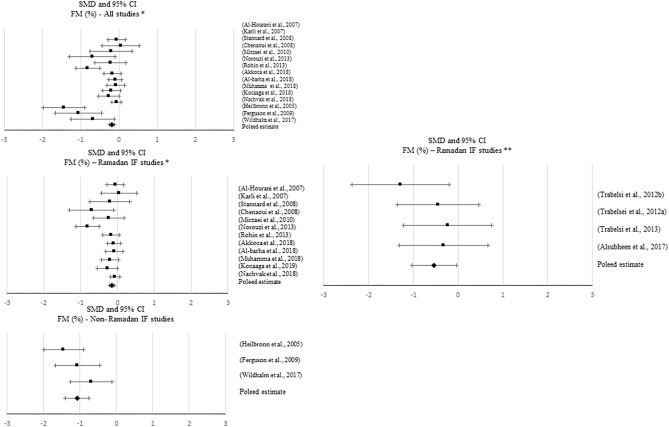
Forest plot of the effects from a random-effects meta-analysis shown as standardized mean difference with 95% confidence intervals on absolute fat mass (FM) for all studies and only non-Ramadan IF studies. For each study, the square represents the standardized mean difference between pre-post data intervention and control groups, with the horizontal line intersecting it as the lower and upper limits of the 95% confidence interval. Forest plot of the effects from a random-effects and fixed-effects, respectively, meta-analysis shown as standardized mean difference with 95% confidence intervals on absolute FM for all studies and only non-Ramadan IF studies. For each study, the square represents the standardized mean difference between between pre- and post-intervention time points. The rhombi represents the pooled estimated standardized mean difference. *Pre-post tests, IF intervention; **Pre-post tests, IF intervention vs. control.